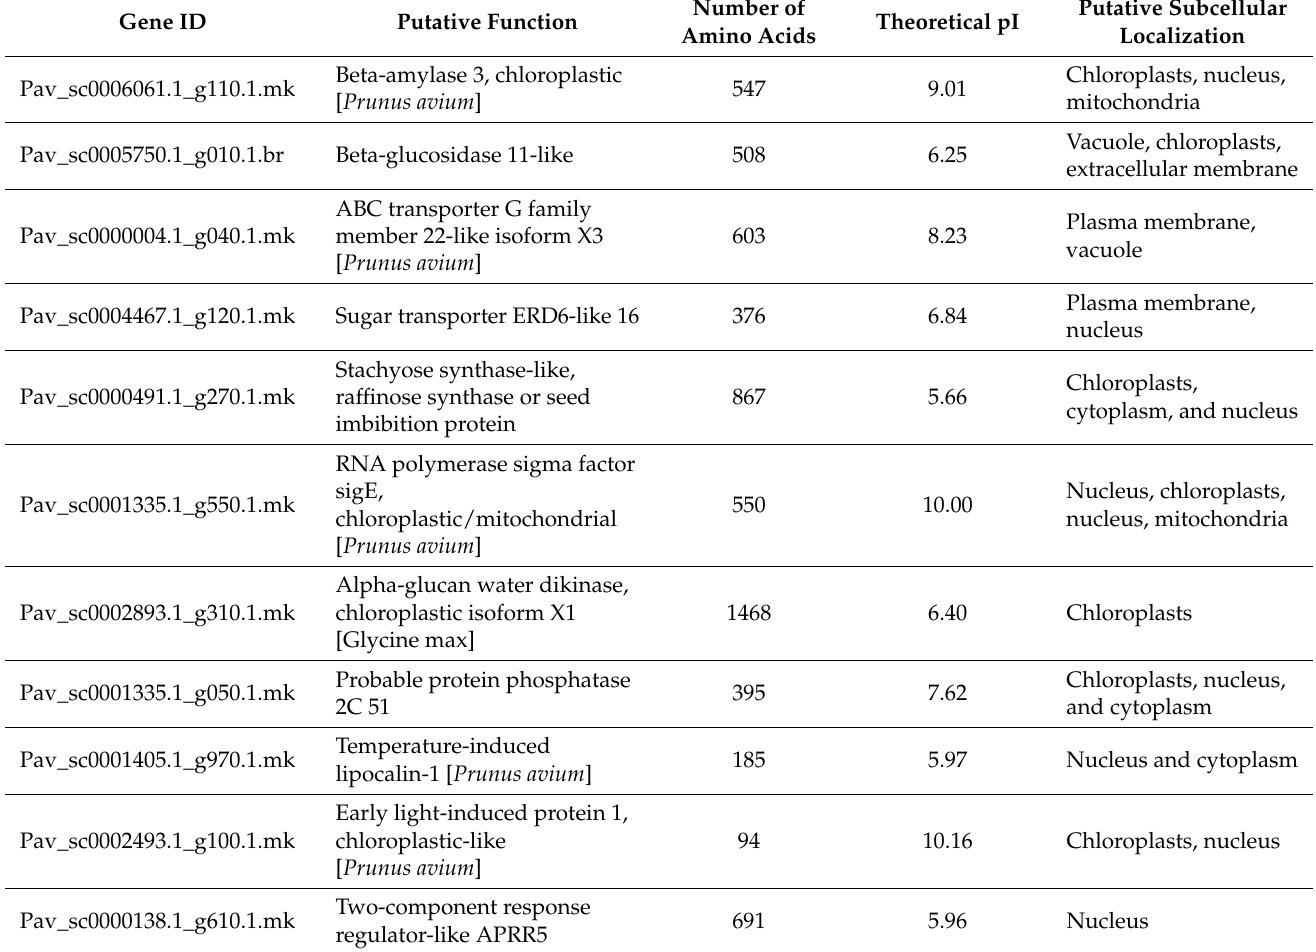
Table 3. Biological information on core candidate genes in the responses of cherry rootstocks to drought. Gene ID Putative Function